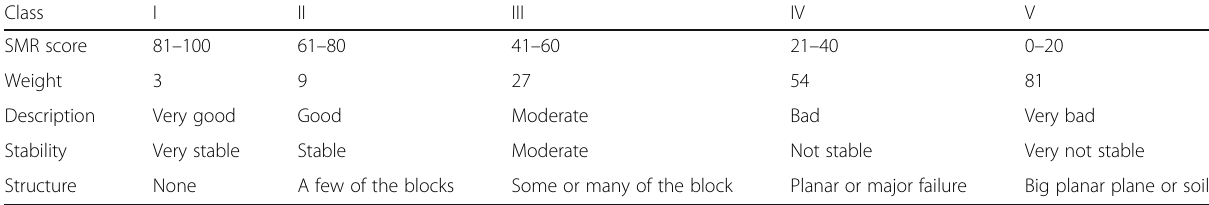
Table 10 Slope Mass Rating (SMR) description (Romana 1993) Class